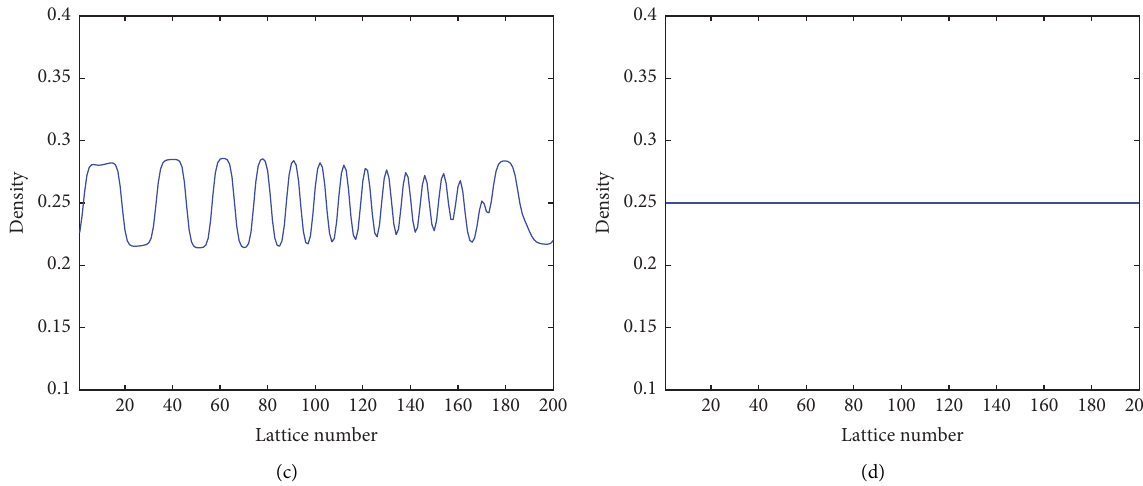
Figure 7: The density profile at t � 10200 with different values of p : (a) p � 0; (b) p � 0 . 05; (c) p � 0 . 1; (d) p � 0 . 15.